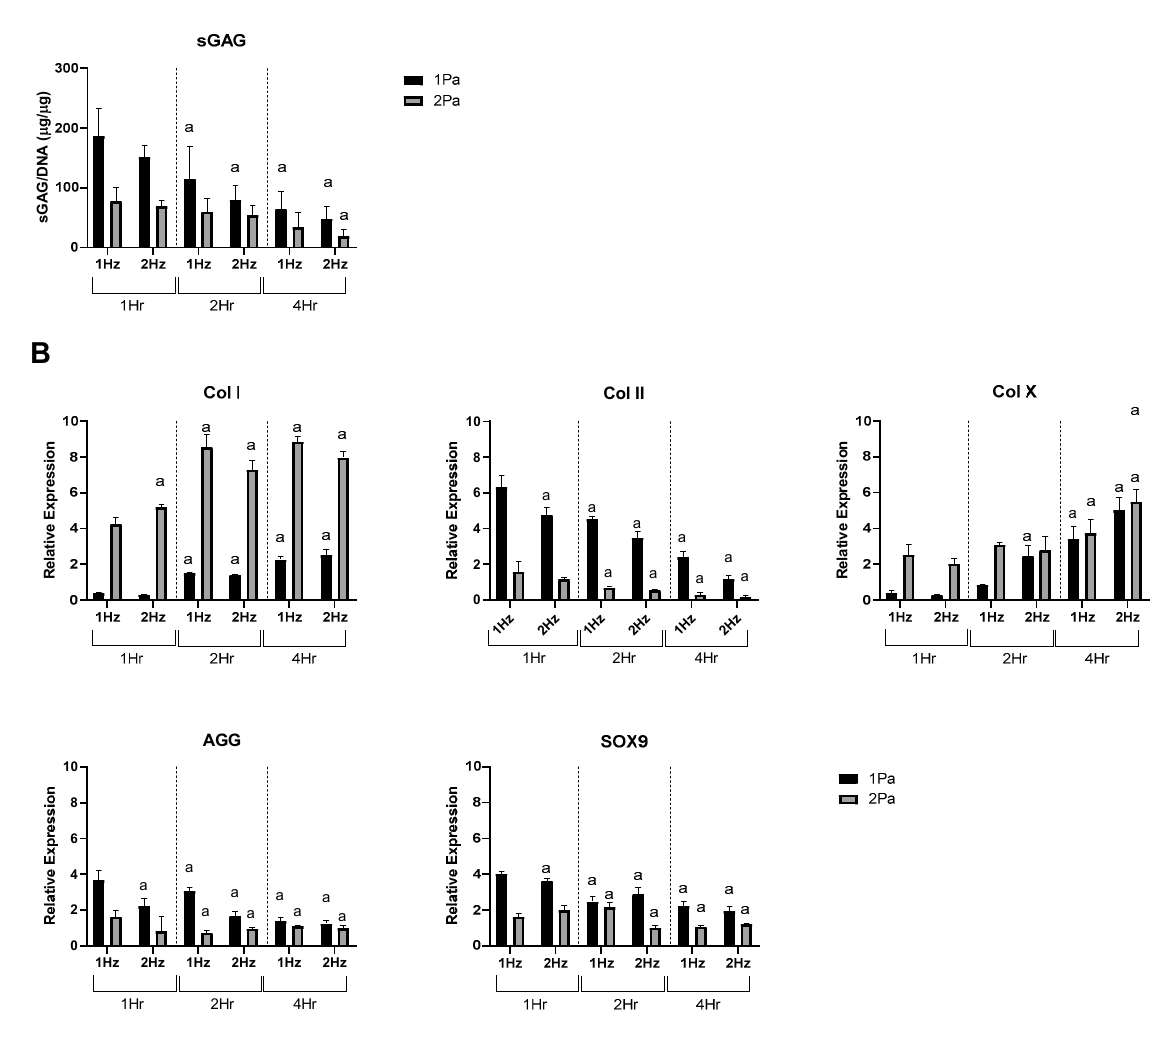
Figure 4. Effect of frequency and duration of FFSS conditions on primary ACs at 1 and 2 Pa on sGAG and gene expression. ( A ) AC sGAG levels normalized to DNA content. ( B ) Gene expression levels for collagen type I, II, and X, SOX9, by ACs via RT-PCR. Expression data were calculated using the 2 −ΔΔ Ct method relative to averaged baseline samples and normalized using 18S as an endogenous control. Statistical differences are shown where (a) represents a significant difference compared with conditions (1 or 2 Pa) at 1 Hz at 1 h, to the level of p < 0.05.